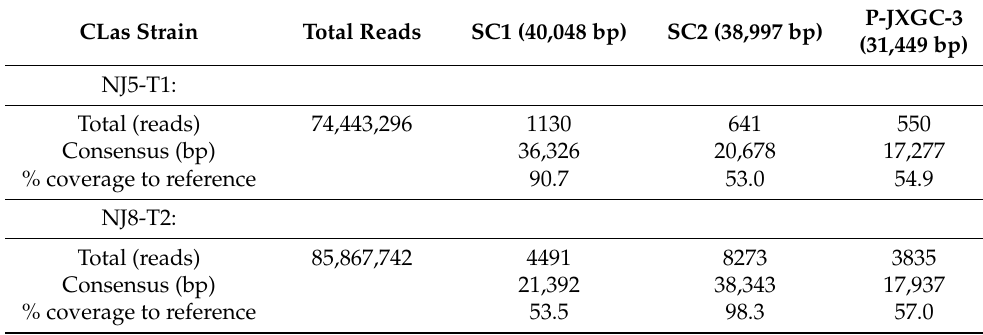
Figure 1. Detection of three phages in “ Candidatus Liberibacter asiaticus” (CLas) strains using standard agarose gel PCR with phage-type-specific primer sets. Lane M, DNA ladder (top to bottom: 3000, 2000, 1550, 100, 750, 500 bp). Type 1 = specific primer sets: 1, T1-2F/T1-2R and 2, T1-3F/T1-3R; Type 2 = specific primer sets: 3, T2-2F/T2-2R and 4, T2-3F/T2-3R; Type 3 = specific primer sets: 5, 891-1F/891-1R and 6, 891-2F/891-2R. [8]. Ct values were based on primer set CLas4G/HLBr [17]. Table 2. Results of HiSeq read mapping to reference phage sequences of SC1 (Type 1, HQ377372), SC2 (Type 2, HQ377373), and P-JXGC-3 (Type 3, KY661963) of “ Candidatus Liberibacter asiaticus” (CLas). CLas Strain